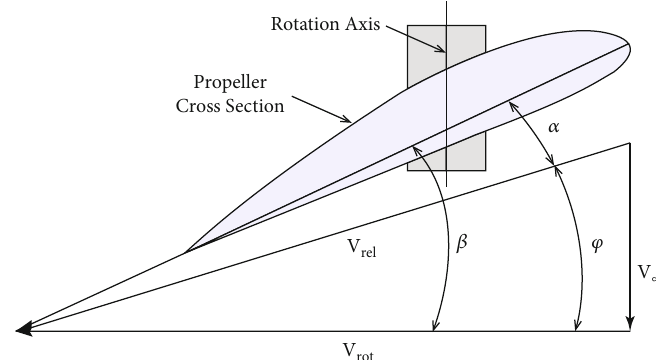
Figure 3: Cross-section of the blade with velocity diagram [21, 22].